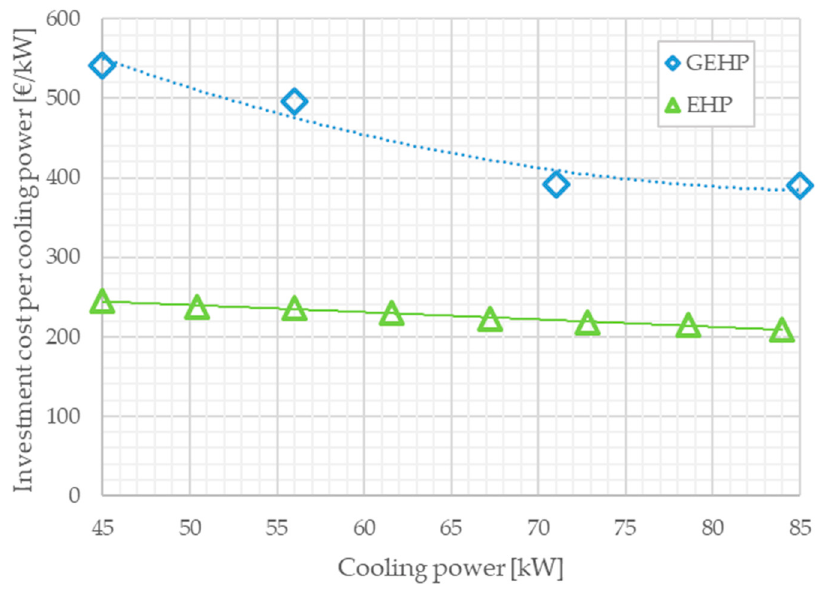
Figure 5. Investment cost per kW of cooling power for GEHPs and EHPs.